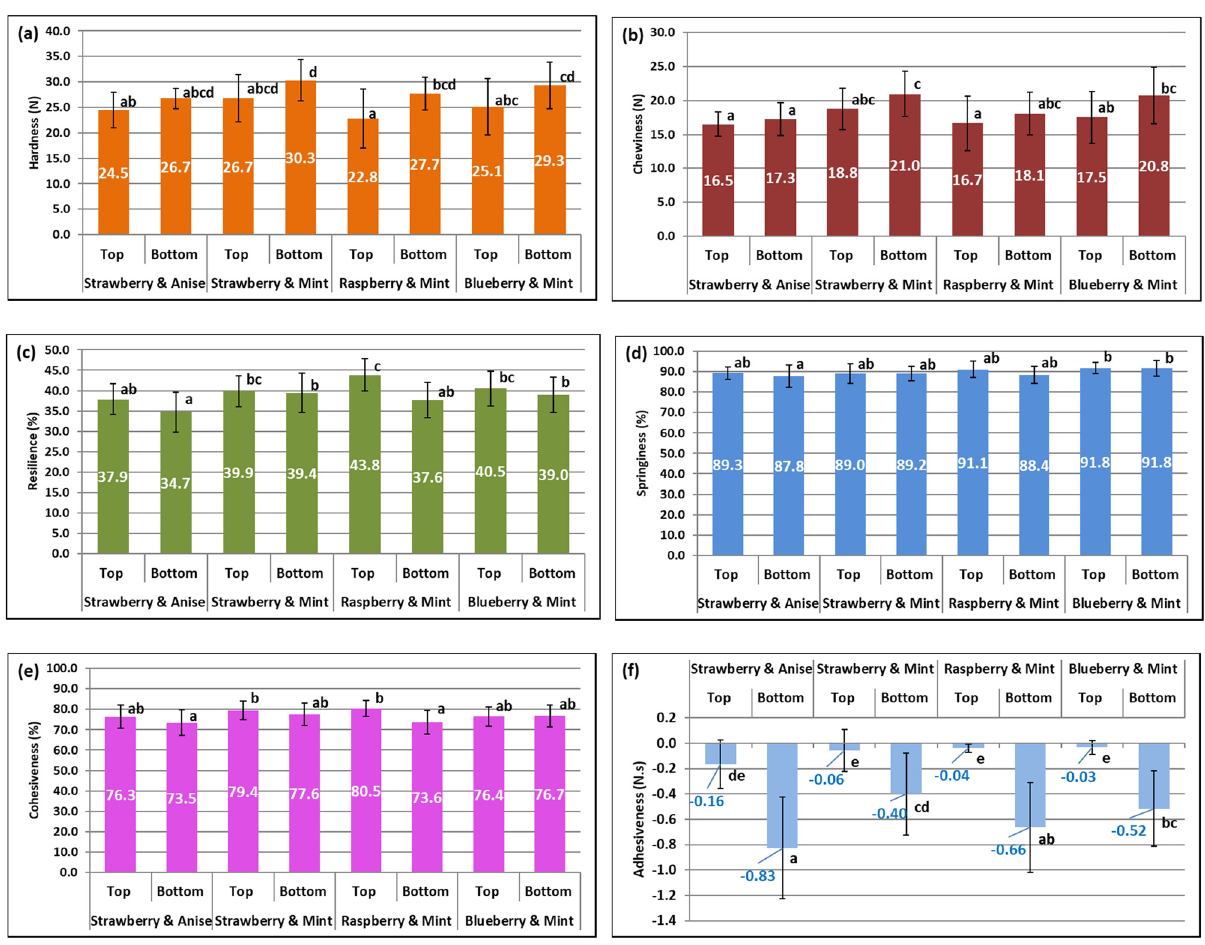
Figure 3: Textural properties on top and bottom faces of the jelly gums, obtained by the compression test: ( a ) hardness, ( b ) chewiness, ( c ) resilience, ( d ) springiness, ( e ) cohesiveness and ( f ) adhesiveness ( bars with the same letter are not statistically di ff erent at 5% signi fi cance level – ANOVA with Tukey test )